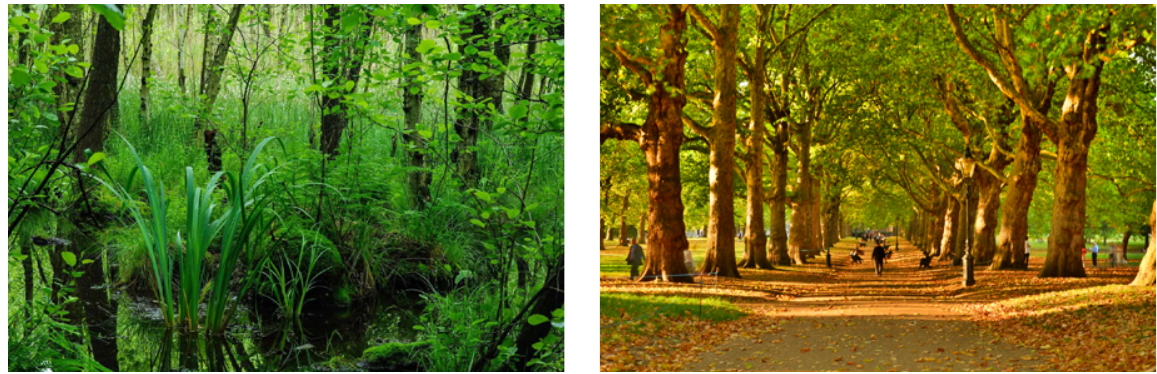
FIG. 4 (Image on left) Natural Environment. Image Credit: © European Wilderness Society [https://wilderness-society.org/ active-no-active-management/]; (Image on right) Artificial Environment. Image Credit: © Garry Knight [https://www.flickr.